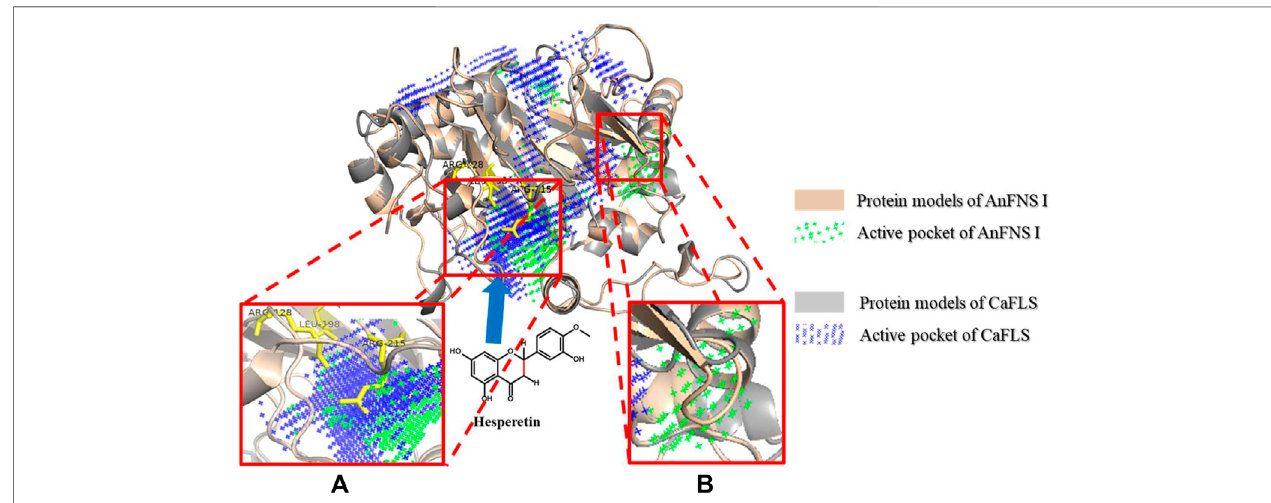
FIGURE4| Major activepocketdifference between AnFNS IandCaFLS. Note: (A) Active pocket difference1(APD 1). (B) Activepocket difference 2(APD 2). Blue arrows indicate the direction of substrate movement into APD 1 by the entrance.